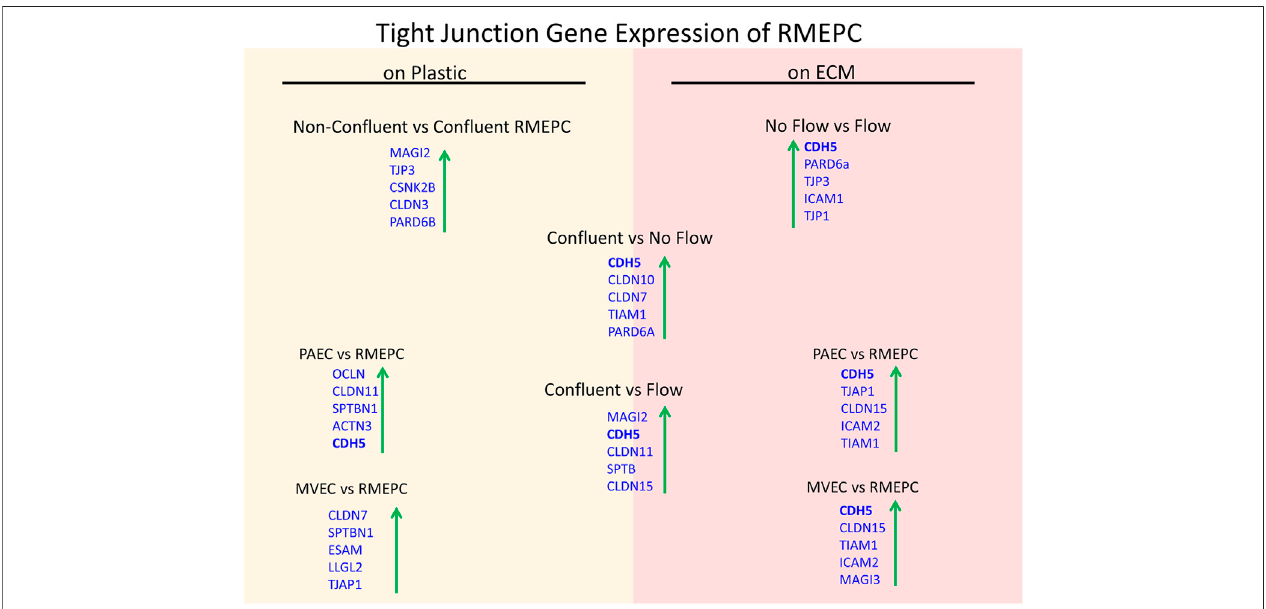
FIGURE 6 | Con fl uency, extracellular matrix and no- fl ow conditions promote the highest expression of tight junction genes by RMEPCs. Top left shows the top upregulated tight junction genes in response to con fl uency on RMEPCs cultured on plastic. Bottom left shows the increase in genes in con fl uent RMEPCs compared to con fl uentPAECs and MVECs cultured onplastic. Theright-hand side(red) showsday 7geneexpression when seeded byperfusion ondecellularizedmouse lung ECM. ThebottomrightshowsthetoptightjunctiongenesupregulatedinRMEPCsvs.PAECsandMVECsonECM(with fl ow)after7 days.Themiddleportionshowsthe increases in tight junction genes inRMEPCin conditions vascular fl owand no- fl ow for7 days compared to con fl uency on plastic. The far top right compares no- fl owvs. fl ow of RMEPCs on ECM.